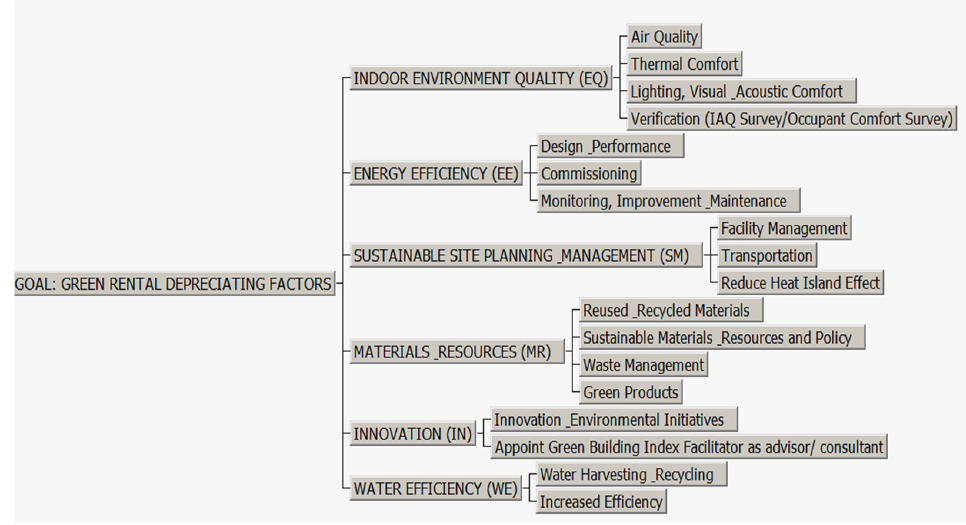
Figure 2. Green rental depreciation hierarchy model.